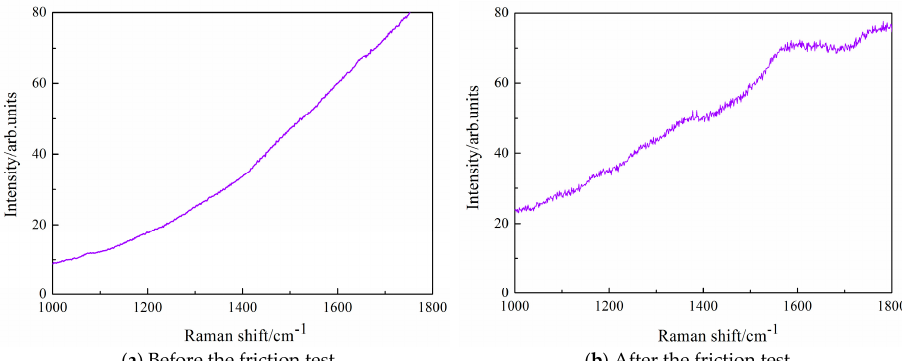
Figure 11. Raman spectra of the transferred films on the worn surface of ZrO 2 ball: ( a ) before the friction test; ( b ) after the friction test.